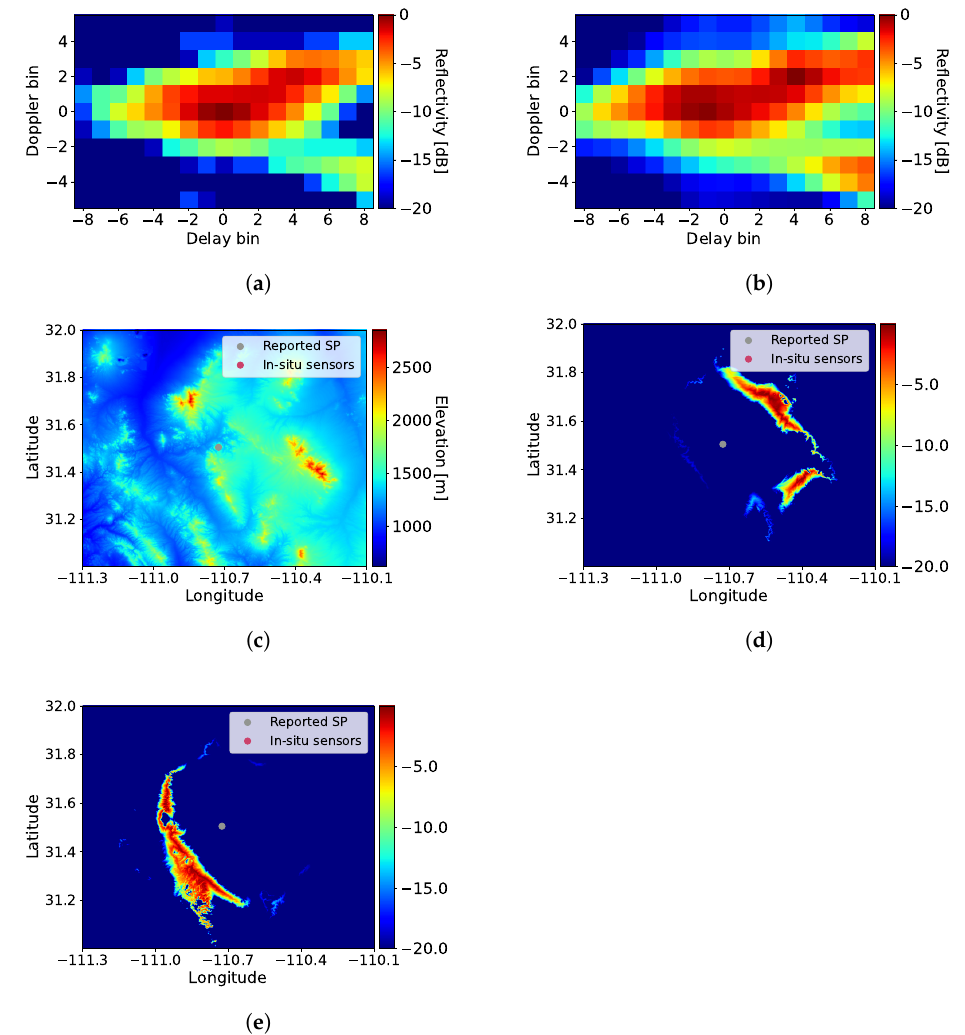
Figure 10. DDM of sample 70,682 of WG track 1: ( a ) Normalized CYGNSS DDM; ( b ) Normalized IGOT DDM; ( c ) DEM; ( d ) WAF projection of DDM cell (4, 2); ( e ) WAF projection of DDM cell (8, − 3). The second DDM is sample 70,693 of WG track 1, the closest DDM to the Lucky Hills site from the west. This DDM SP is located at 31.724 ◦ latitude and − 110.072 ◦ longitude, with a reported SNR of 5.5 dB. Furthermore, the normalized reflectivities of the CYGNSS DDM and the IGOT model DDM are shown in Figure 11a,b, respectively. Moreover, the elevation map of the area close to the SP location is shown in Figure 11c. This DDM has non-zero cells in the negative delay. In a DDM, no return is expected before the SP. To understand this phenomenon, the WAF projection of cell ( − 7, 3) was examined, the cell that has the highest reflectivity in the negative delay part of the DDM. The WAF projection of this cell is presented in Figure 11d. It shows that the cell scattering area is around the CYGNSS reported SP location. On the other hand, the WAF projection of the DDM SP (0, 0) shows that its scattering area is on the west side of the reported SP location, as shown in Figure 11e. This DDM has two strong scattering areas, where the DDM is centered on the strongest. The first scattering area is associated with the reported SP location, which contains the valley, as shown in Figure 11d. The other scattering area is associated with the high elevation area and its slope, as shown in Figure